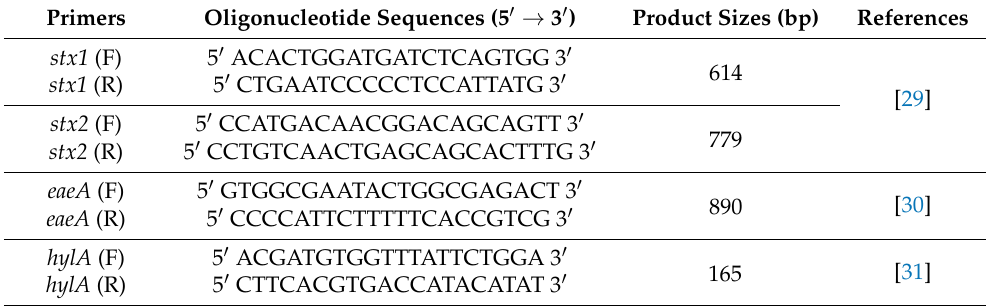
Table 1. Oligonucleotide primers adopted for amplification of the various virulent genes in E. coli . Primers Oligonucleotide Sequences (5 (cid:48) → 3 (cid:48)